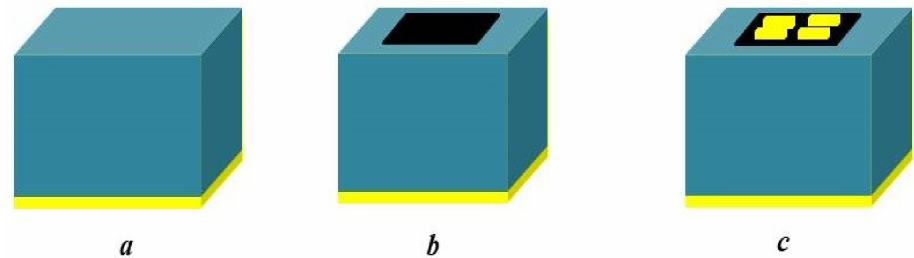
Figure 2. Development stages of the proposed absorber. ( a ) Stage I, ( b ) Stage II ( c ) Final design.